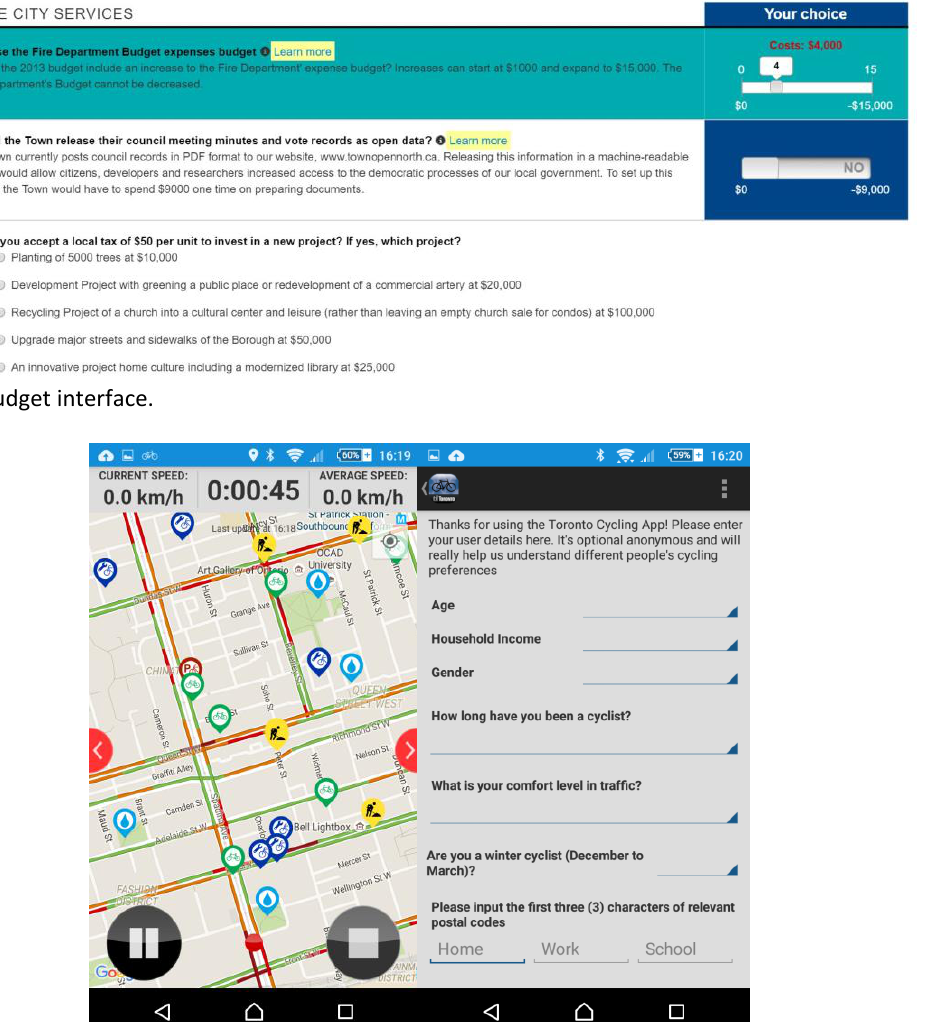
Figure 2. Toronto Cycling App